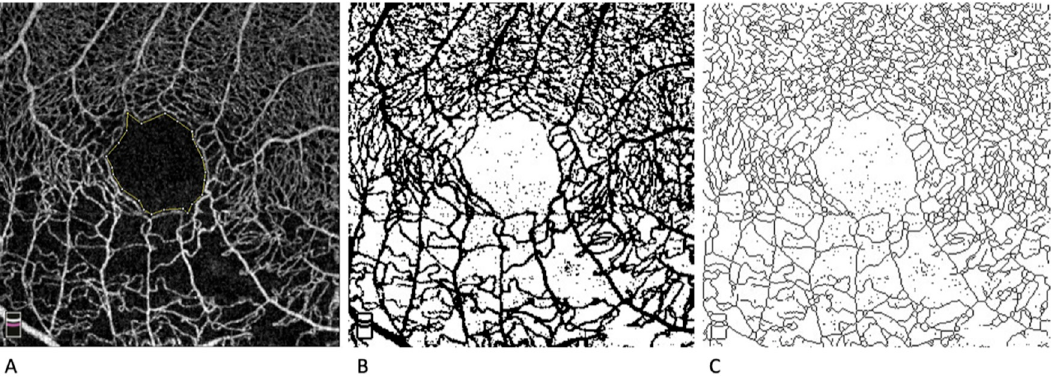
Figure 1. Optical coherence tomography (OCTA) image processing. ( A ) 3 × 3 mm OCTA image centered on the fovea in an eye with central retinal vein occlusion (CRVO) and previously treated macular edema. The foveal avascular zone area (FAZ) was manually traced ( yellow line ). ( B ) Binary conversion of the same image used to measure the vessel density (VD). ( C ) Binarized and skeletonized image used to measure the vessel length density.